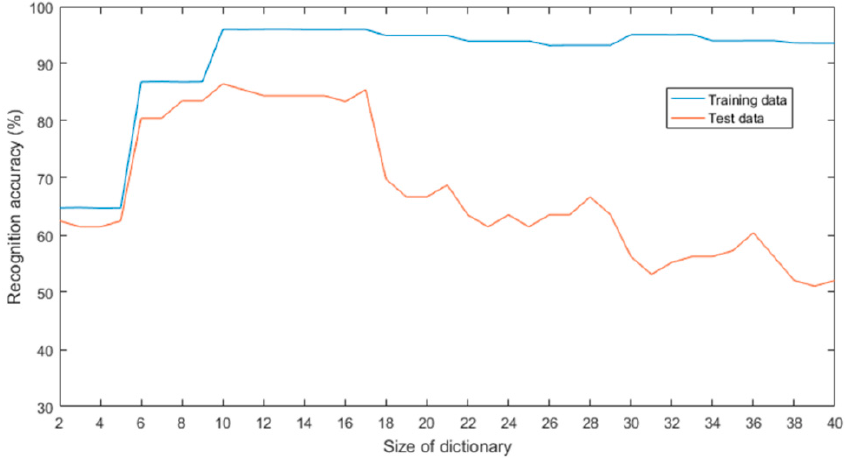
Figure 7. The recognition accuracy of different dictionary sizes. Table 6. The classification accuracy when different sensor responses are chosen to initialize the dictionary. Sensors